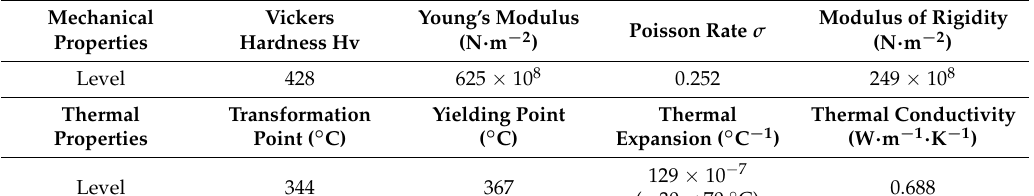
Table 2. Optical glass mechanical and thermal properties.